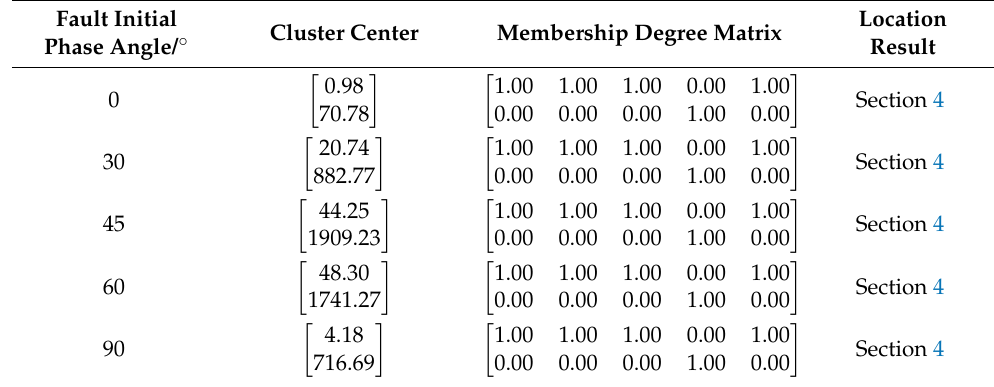
Table 3. Location results of different fault initial phase